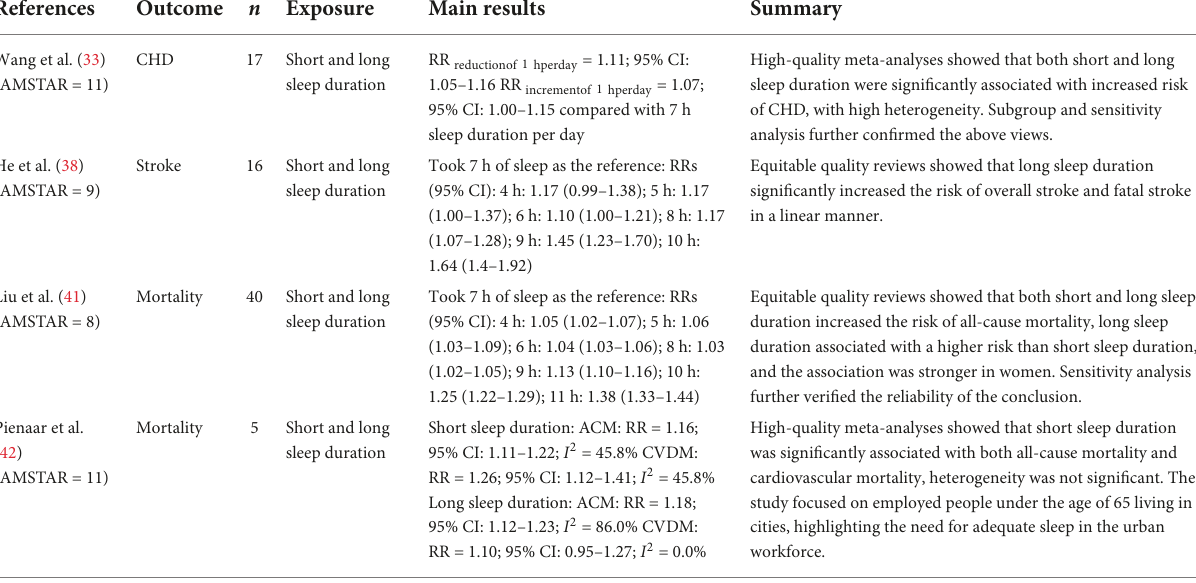
TABLE 1 Sleep duration and cardiovascular diseases in observational